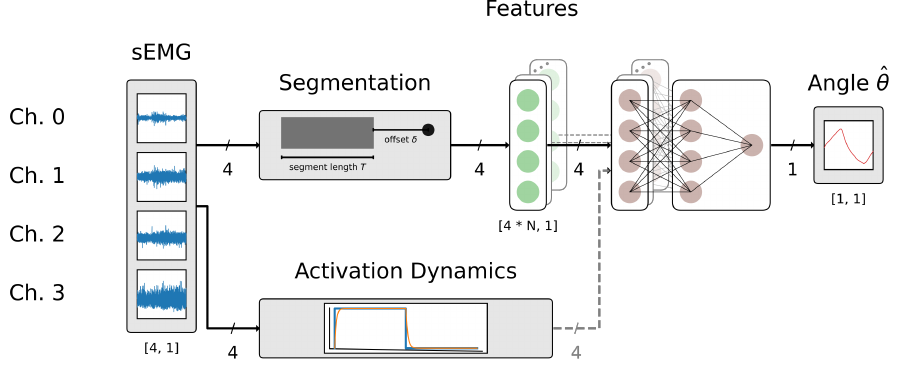
Figure 1. Schematic illustration of the procedure for evaluating different features and feature com- binations, as well as segmentation parameters for predicting elbow-joint movement by an FFNN based on sEMG data. Depending on which features were evaluated, the sEMG data were either segmented , or directly processed by a muscle activation dynamics model . All features served either as single features , or in various multi-feature combinations as input signals to an FFNN that was trained to predict the corresponding angle of an elbow joint ˆ θ . Note that the input layer of the FFNN scaled with the number of features used ( N input = N channels · N features